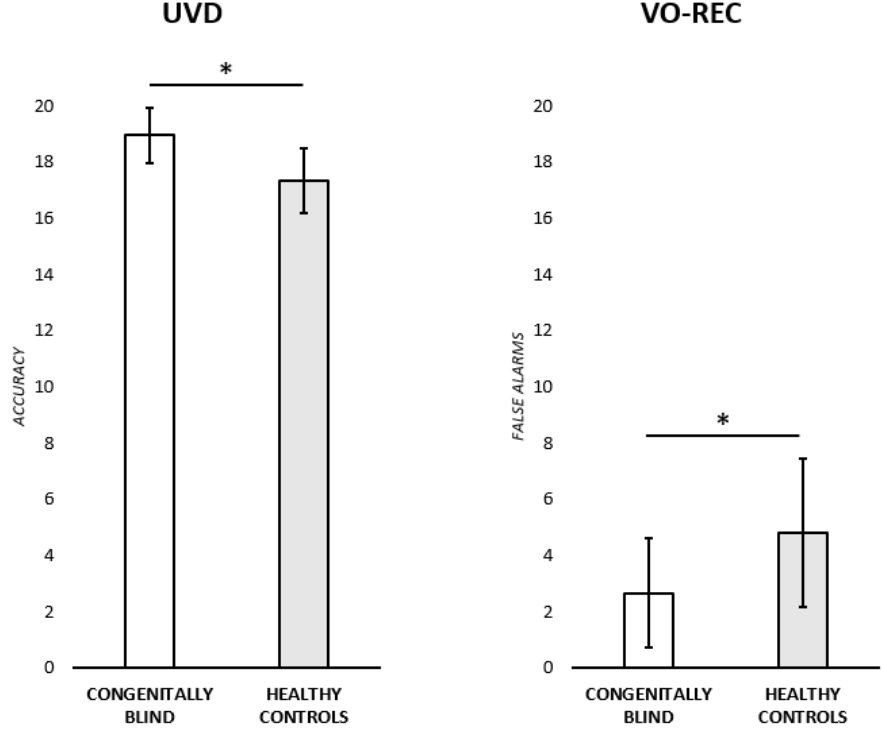
Figure 1. On the left, adjusted accuracy score at the unknown voice discrimination test; on the right, FAs adjusted score at the VO-REC. * Significant difference.